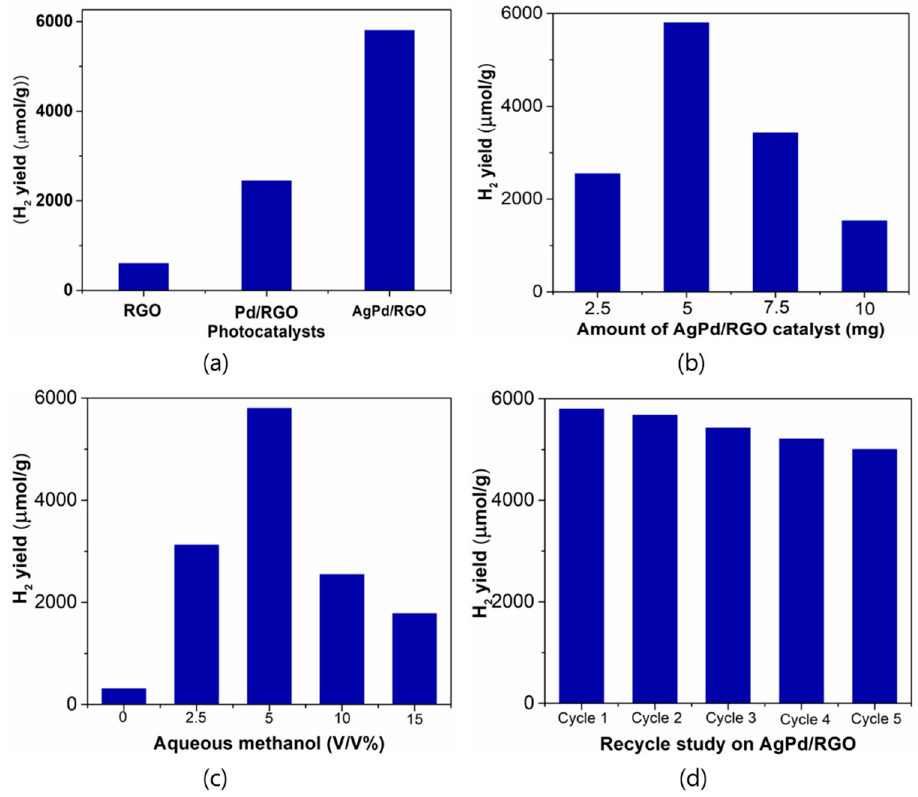
Figure 7. ( a ) Photocatalytic H 2 production with prepared catalysts ( b ) Different amounts of Pd-Ag/rGO catalyst for H 2 production ( c ) Different amounts of sacrificial agent (methanol) for H 2 production ( d ) Reusability test for H 2 production using Pd-Ag/rGO photocatalyst.